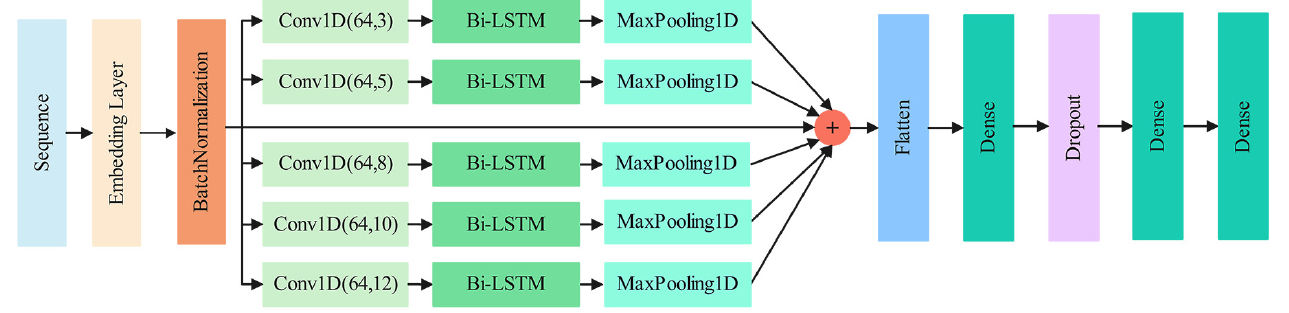
Figure 4. Venn diagram of the dataset.